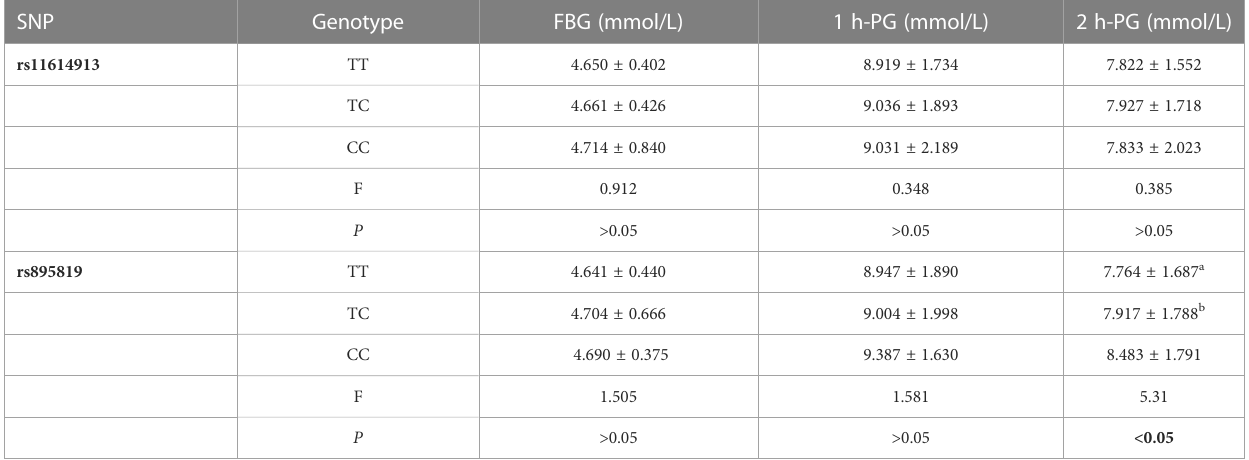
TABLE 5 Relationship between polymorphisms genotype and blood glucose